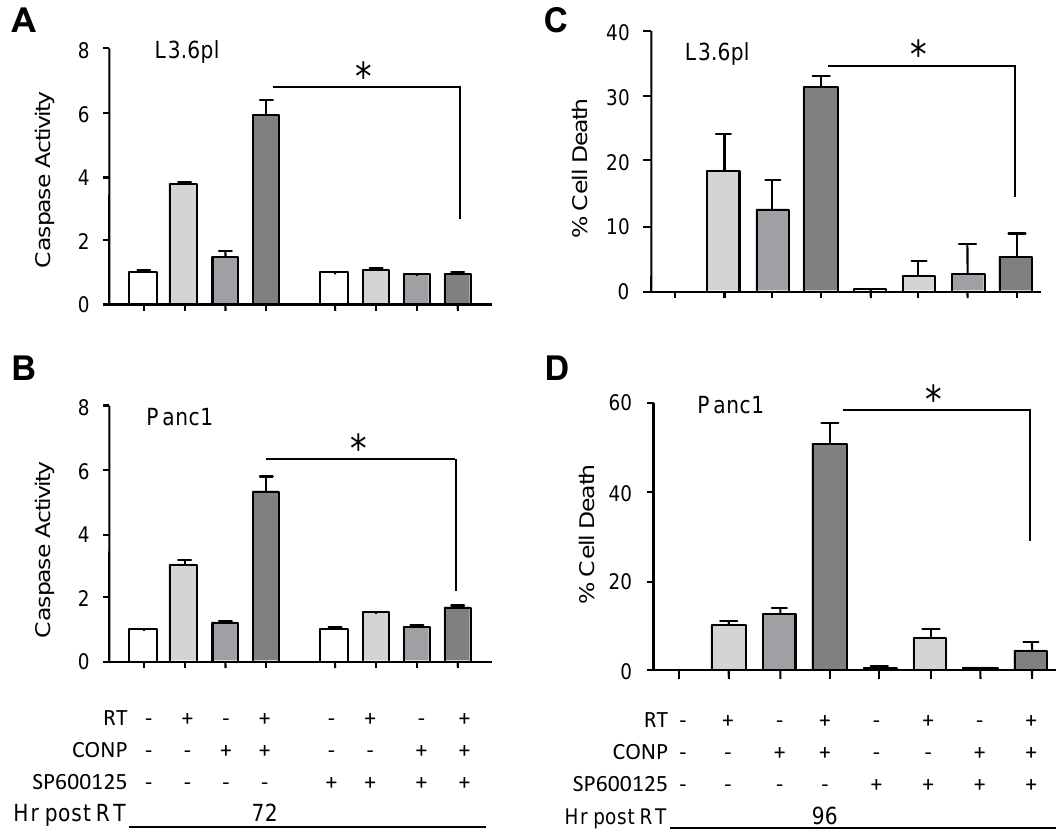
Figure 6. CONPs are Unable to Drive RT-Induced Apoptosis in the Absence of JNK Function. Cells were treated with or without 20 µM specific JNK inhibitor (SP600125) plus 0 or 10 µM CONPs for 24 hours prior to exposure to 0 Gy or 5 Gy RT. Caspase 3/7 activation ( A , B ) and cell viability ( C , D ) were determined 72 and 96 hours post RT, respectively. Results were normalized to untreated control group. The control viability value was set as 100% viability. The % cell death was calculated by subtracting % viability from 100%. * p < 0.001. (see Figure S2 for similar results obtained when JNK expression was knocked down).